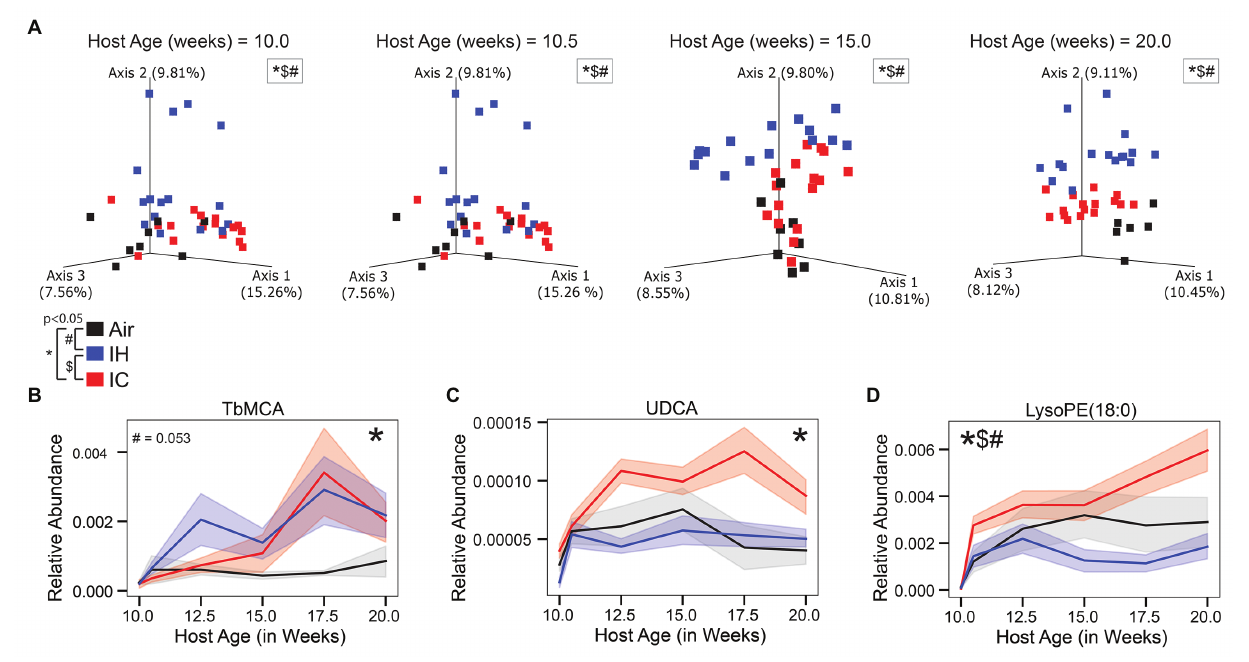
FIGURE 3 | Untargeted LC-MS/MS metabolomics of ApoE −/− mice on HFD during chronic 10-week treatment. (A) Canberra PCoA of the metabolome during four key time points, each time point calculated in isolation. Longitudinal relative abundance values for (B) Tauro- β -muricholic acid (T β MCA; level 1 identification); (C) Ursodeoxycholic acid (UDCA; level 1 identification); and (D) lysophosphoethanolamine 1-stearoyl-2-hydroxy-sn-glycero-3-phosphoethanolamine [LysoPE(18:0); level 3 identification]. PERMANOVA used for statistical comparisons at the population level. LME modeling used for statistical comparisons of individual metabolites over time. The shaded areas in parts (B–D) represent standard error of the mean. Air/controls are black ( n = 6), IH is blue ( n = 12), and IC is red ( n = 12). Statistical significance p < 0.05, *IC vs. Air, # IH vs. Air, and $ IH vs.